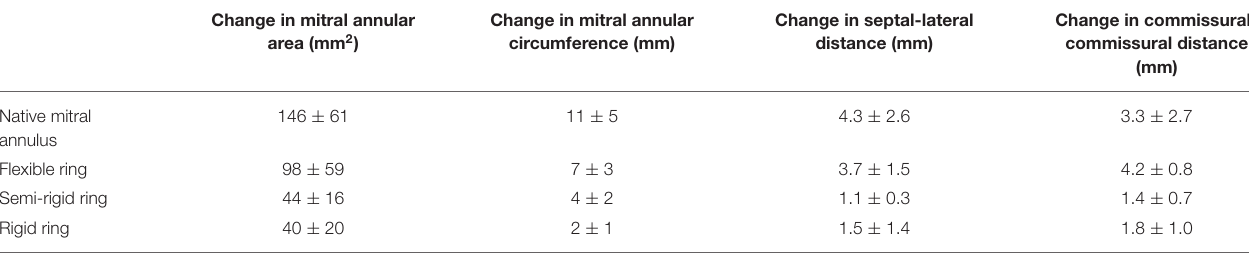
TABLE 4 | Overview of geometric changes in the mitral annulus in accordance with ring type.